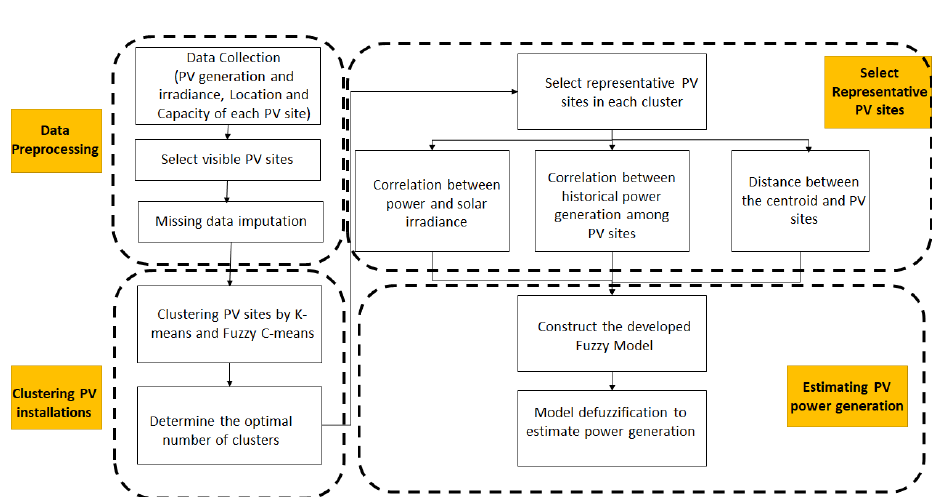
Figure 2. Detailed information for each process.